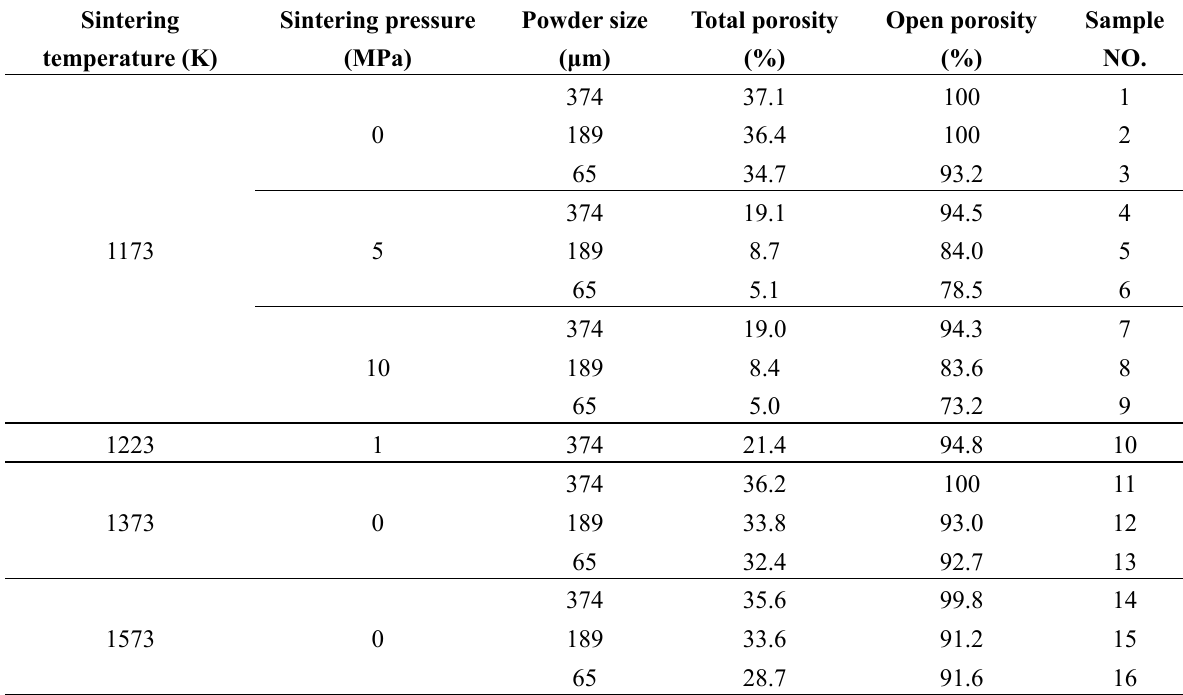
Table 12. The total porosity and open porosity of porous Ti compacts sintered with various powder sizes and sintering conditions [51]. Reprinted with permission from [51]. Copyright 2003